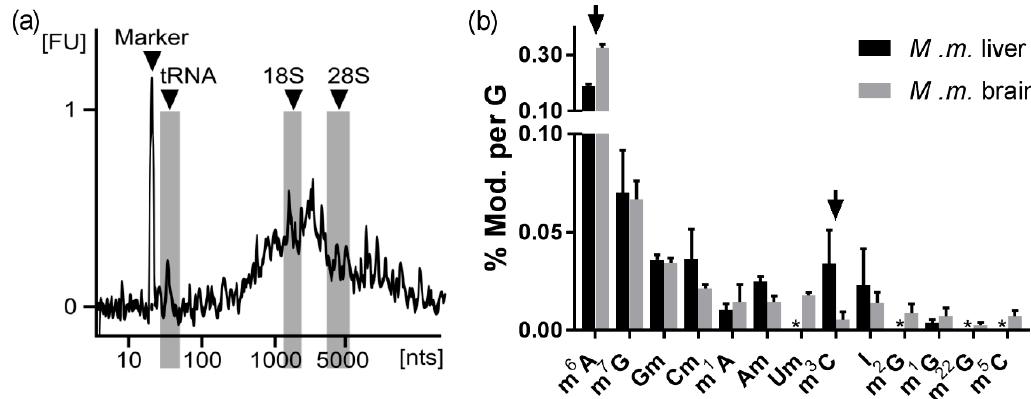
Figure 6. Absolute quantification of mRNA purified from mouse liver and mouse brain. ( a ) The chip electropherogram of mouse brain mRNA shows the expected size distribution from 500–7000 nucleotides. The location of tRNA and ribosomal RNA (18S and 28S) are indicated in grey. ( b ) Modified nucleosides found and quantified in mouse mRNA from brain and liver. Legend: Arrow: Most interesting differences between liver and brain tissue mRNA. *signal detectable but not quantifiable. The average of n = 3 biol. replicates are plotted. The error bars reflect the standard